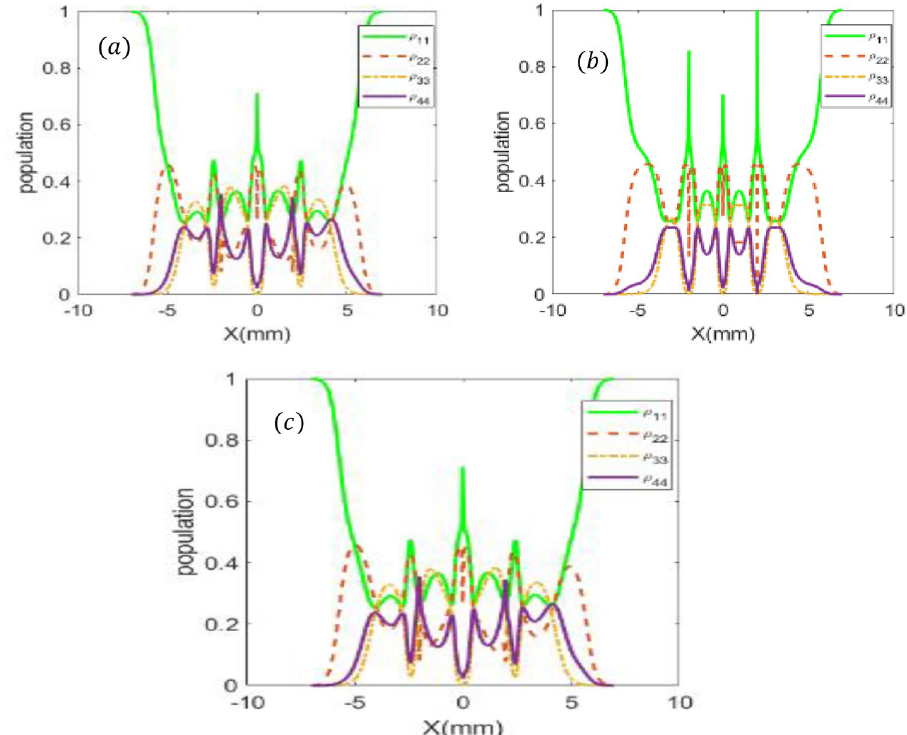
Figure 5. Steady-state behavior of population versus x (y = 0) for l 2 = 2 and l 1 = − 1 (a), l 2 = 1 and l 1 = 1 (b) and l 2 = − 2 and l 1 = − 1 (c). Parameters are p δ = � 1 = � 2 = 0, ω 43 = 0.6 γ , T A = 2 γ , and T B = 7 γ